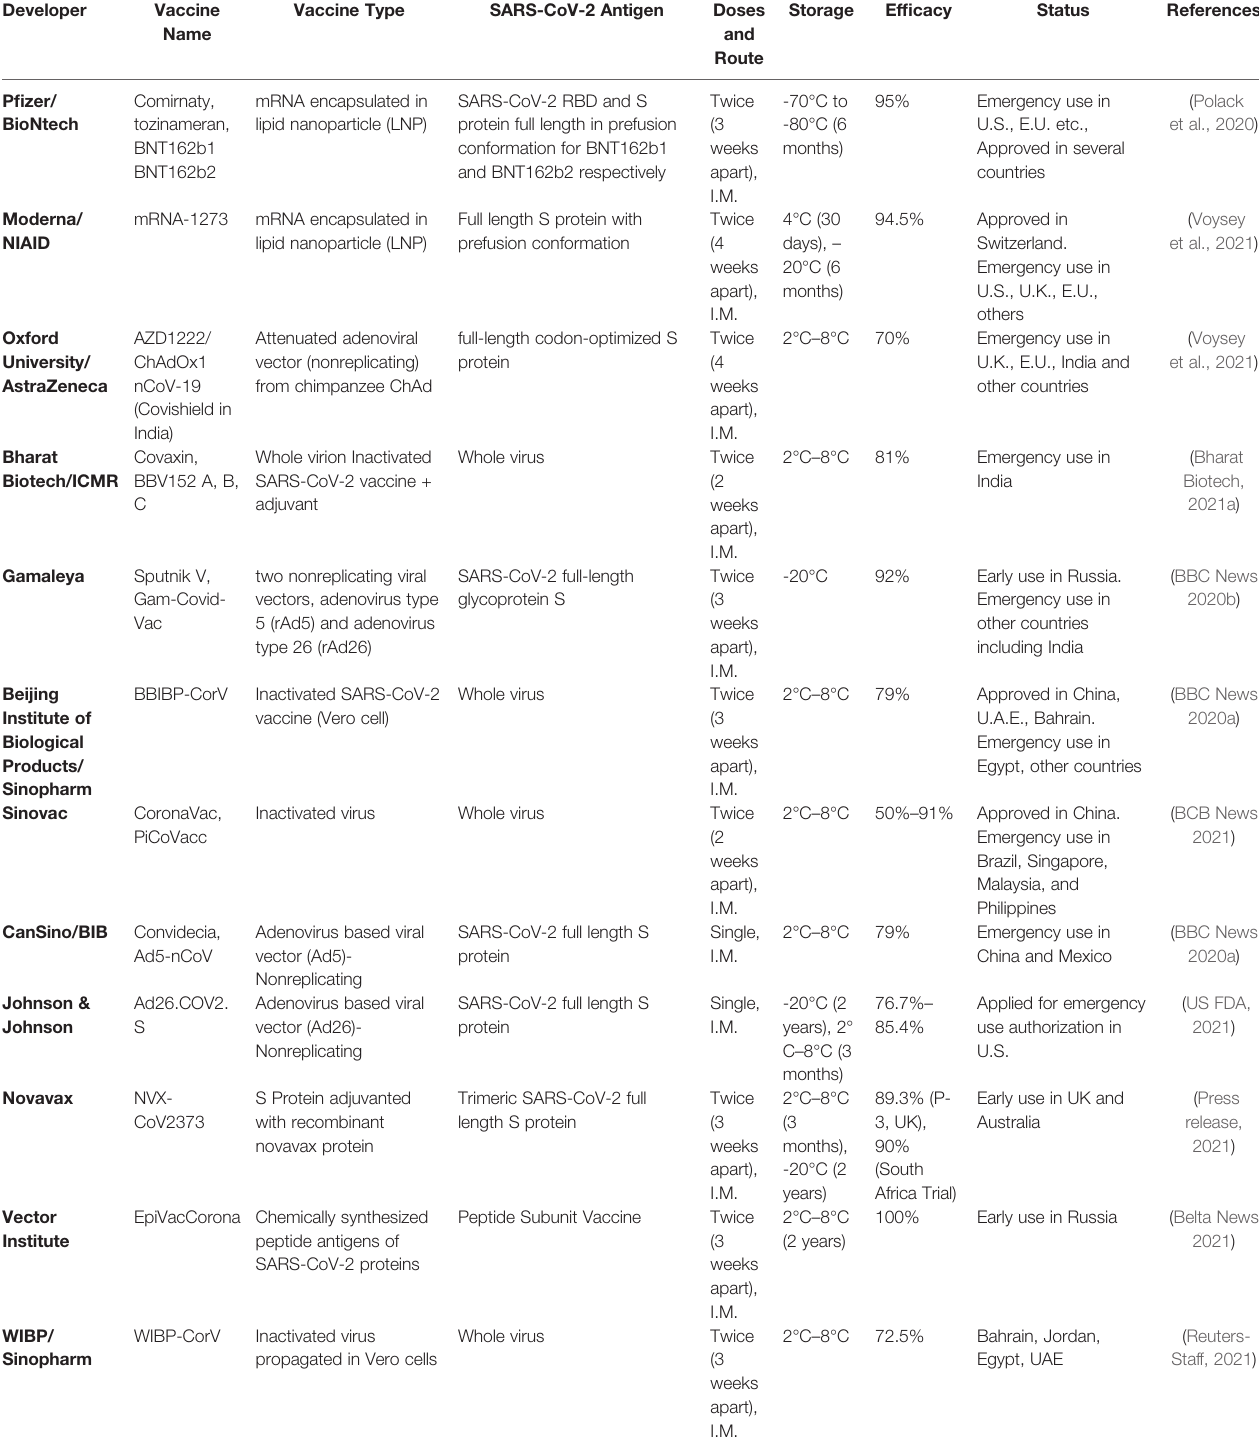
TABLE 2 | List of marketed vaccines against